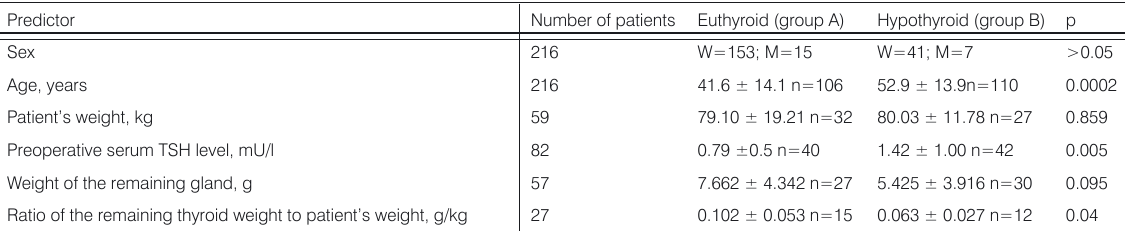
Table 1. Comparative analysis between post-hemithyroidectomy euthyroid and hypothyroid patients.